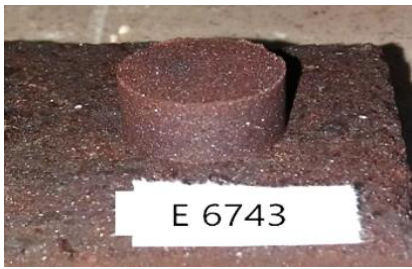
Figure 9. Peridotite sample E6743 without additives after calcination.